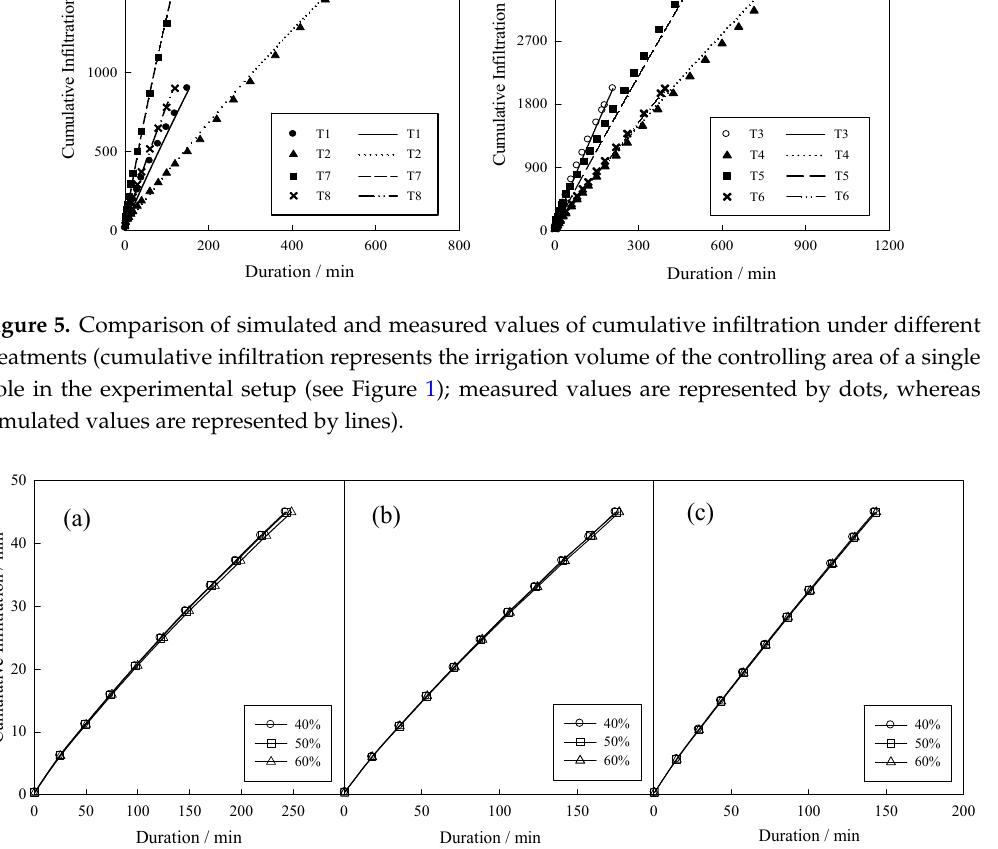
whereas simulated values are represented by lines).